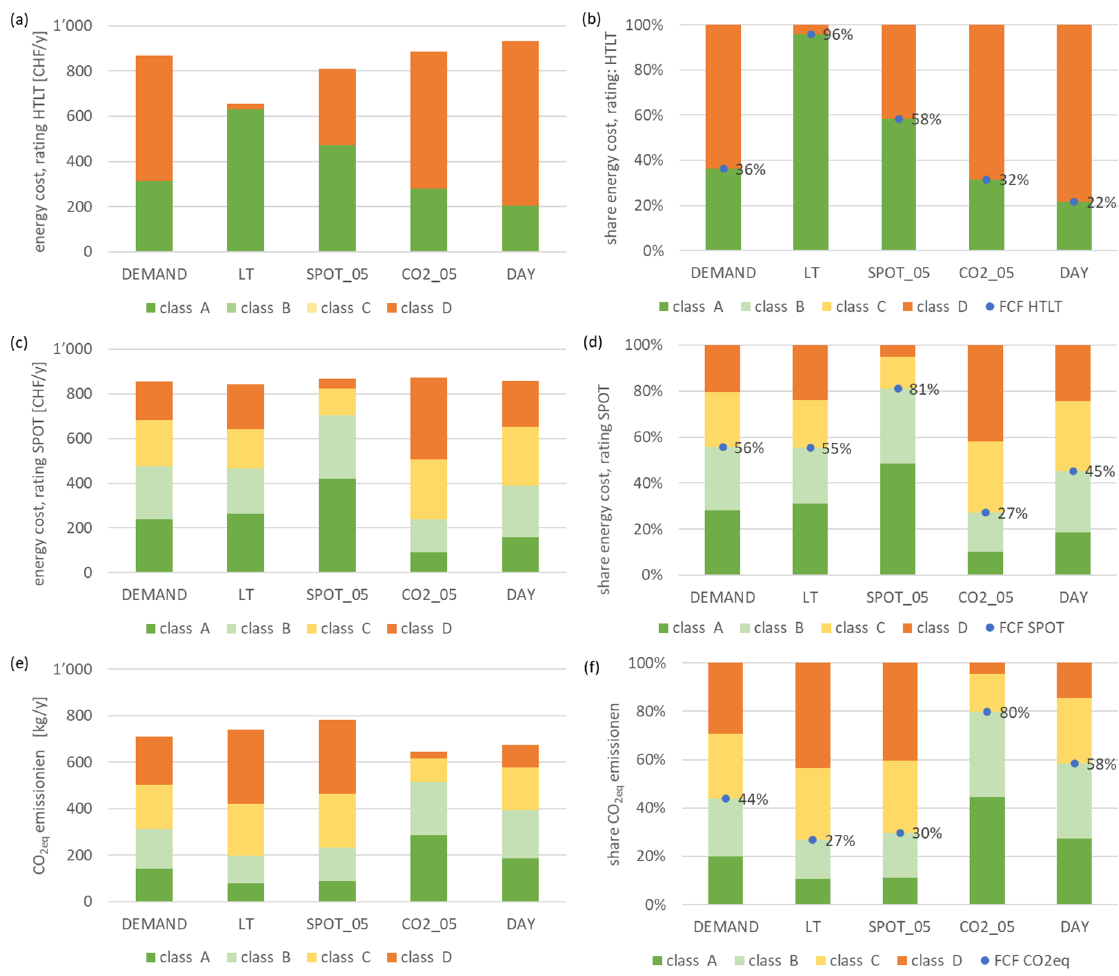
Figure 10. Flexibility classification of energy costs (rating HTLT ( a , b ), rating SPOT ( c , d ) and CO 2eq emissions ( e , f ) without photovoltaic system (left: absolute values, right relative values). The right side includes the FC factors too.